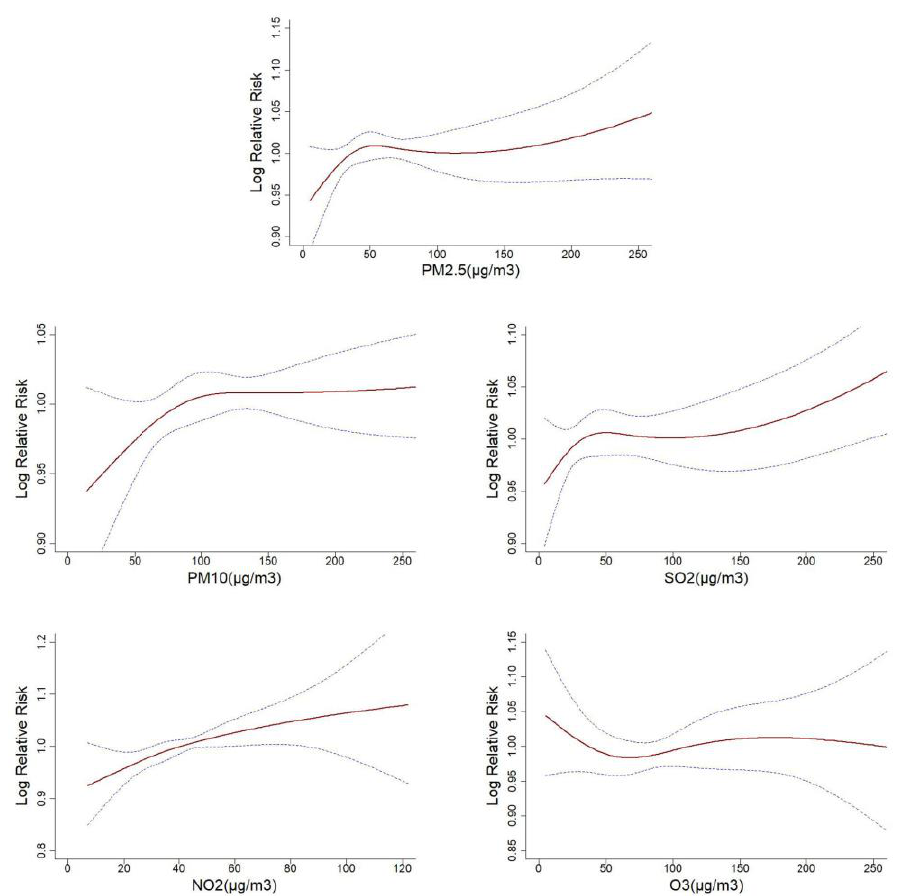
Figure 2. Exposure-response relationships between five air pollutants and respiratory disease hospitalization (The x -axis represented the concentration of air pollutants ( μ g/m 3 ) at the current day, the Y -axis indicated Log relative risk of respiratory disease hospitalization. The blue imaginary lines were the 95% CI. All models were adjusted for time, temperature, relative humidity, weekend and public holiday.).